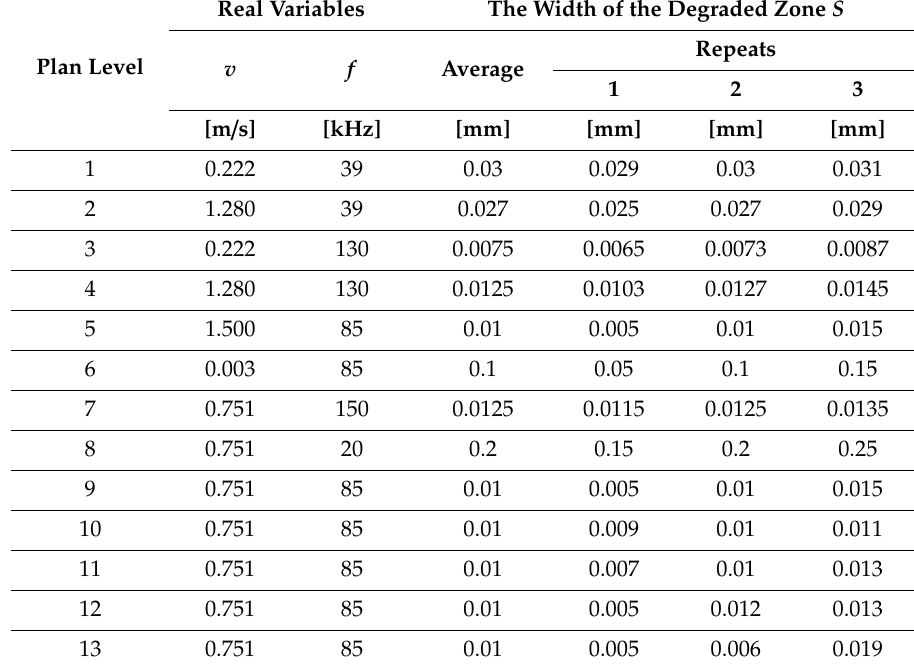
Table 4. The matrix of the experiment plan according to the five-level plan with the results for the film thickness t = 50 µ